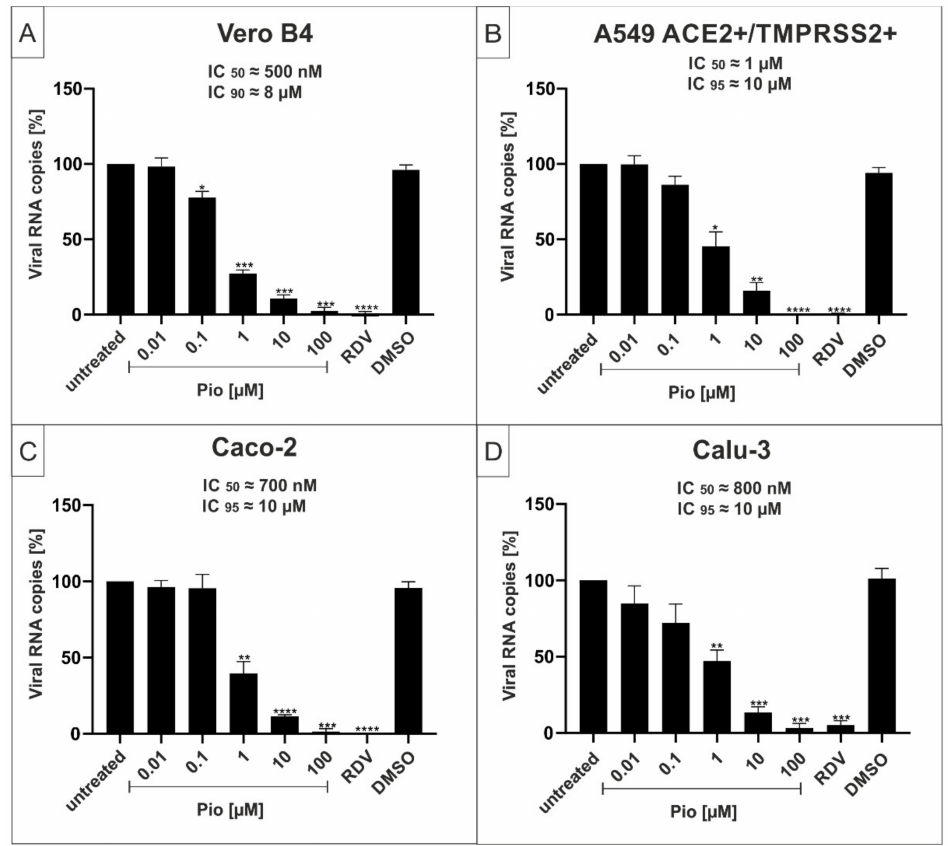
Figure 3. Pioglitazone (Pio) inhibits replication of SARS-CoV-2 Wuhan type with comparable antiviral efficacy in various cell lines. Vero B4 ( A ), A549-ACE2+/TMPRSS2+ ( B ), Caco-2 ( C ), and Calu-3 cells ( D ) were infected with SARS-CoV-2 PR-1 at a MOI of 2 × 10 − 2 . One hour after infection and